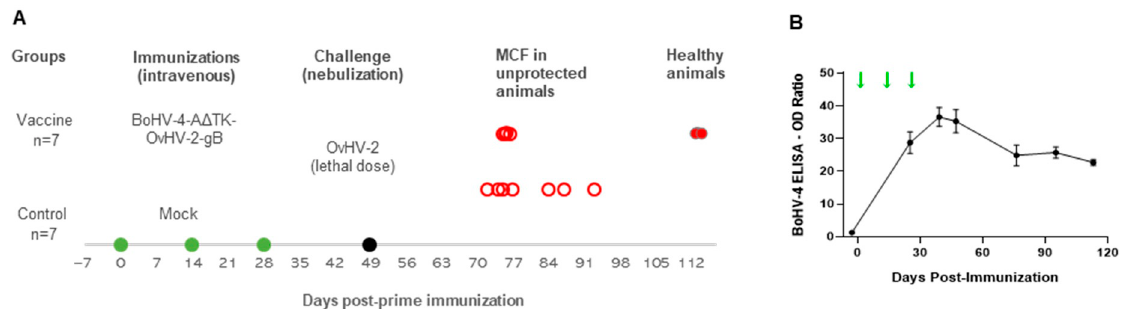
Figure 3. Vaccine-challenge trial in a rabbit model. ( A ) Experimental design and disease outcome upon challenge. Two groups of seven rabbits each were immunized with either BoHV-4-A ∆ TK-OvHV-2-gB or with a mock preparation. Green dots indicate immunizations, the black solid dot indicates challenge, and red circles show the number of animals that developed malignant catarrhal fever (MCF) (open) or remained healthy (solid) until the end of the experiment at 113 days post-prime immunization. ( B ) BoHV-4 antibody response in rabbits vaccinated with BoHV-4-A ∆ TK-OvHV-2-gB, showing mean ELISA OD ratio and SEM. Green arrows indicate immunization times.